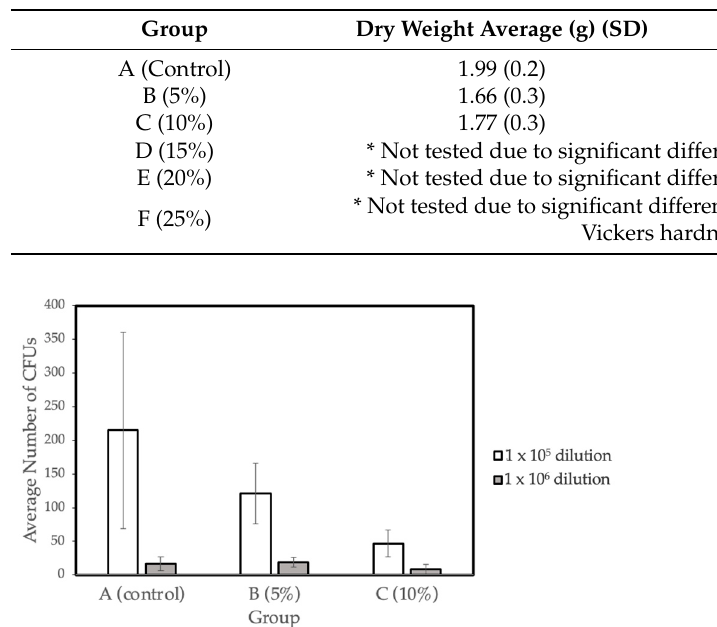
Table 4. Biomass (dry weight) averages for various concentrations of self-cure Gantrez.